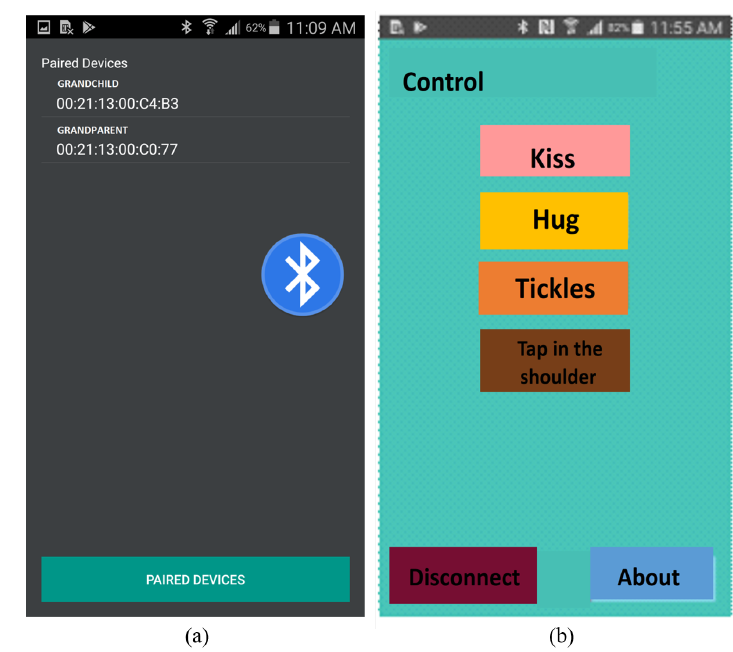
Figure 3. Screenshots of the sender application. ( a ) synchronization between sender and receiver applications and ( b ) GUI of the sender application to send the affection gestures.